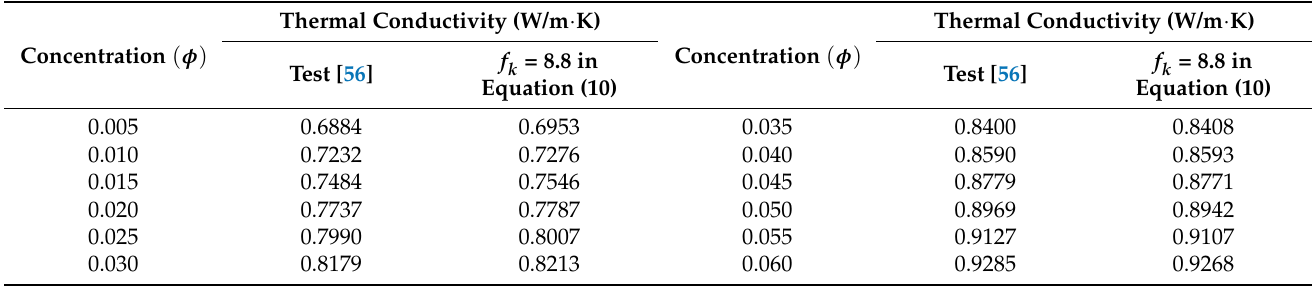
Table 3. Thermal conductivity data of Al 2 O 3 nanofluid at 323 K for different concentrations.